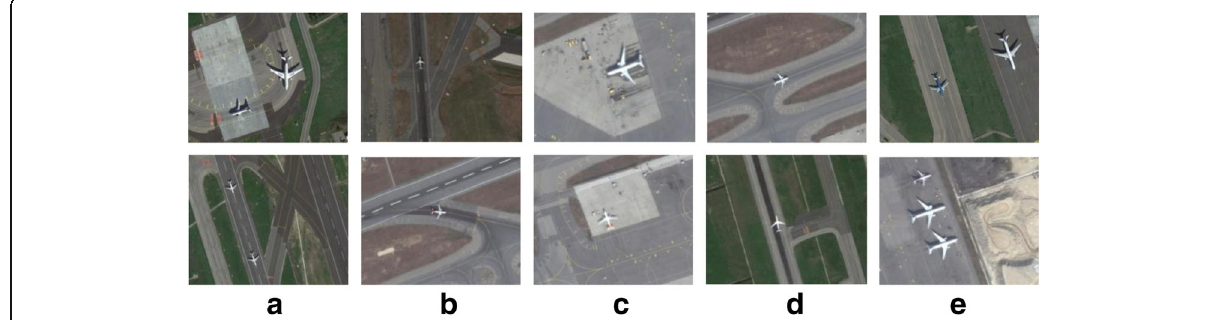
Fig. 4 Aircraft sample set. a The background is mainly made up of grassland. b The background is mainly made up of land. c The background is mainly made up of cement. d A single aircraft in each image. e Multiple aircrafts in each